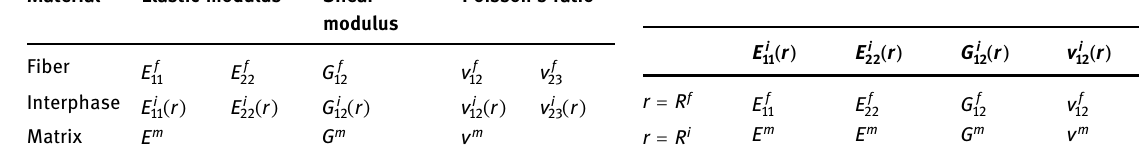
Table 1: Elastic properties of composite constituents Material Table 2: Elastic properties of interphase at the